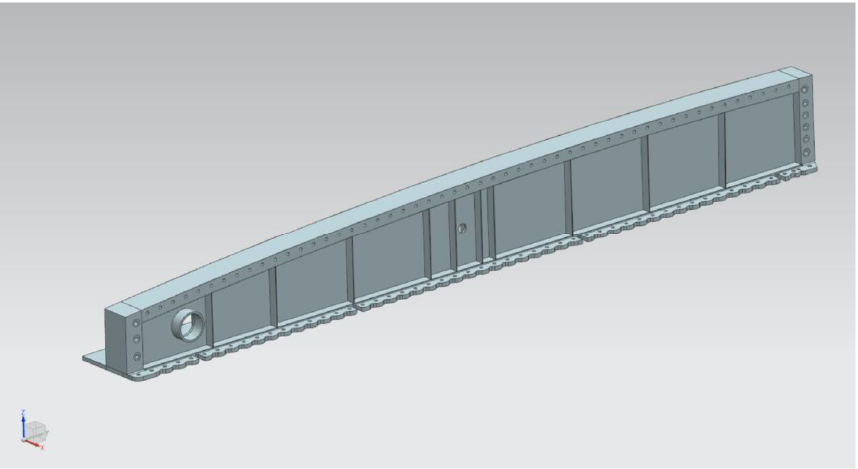
Figure 5. Wing root CAD model.